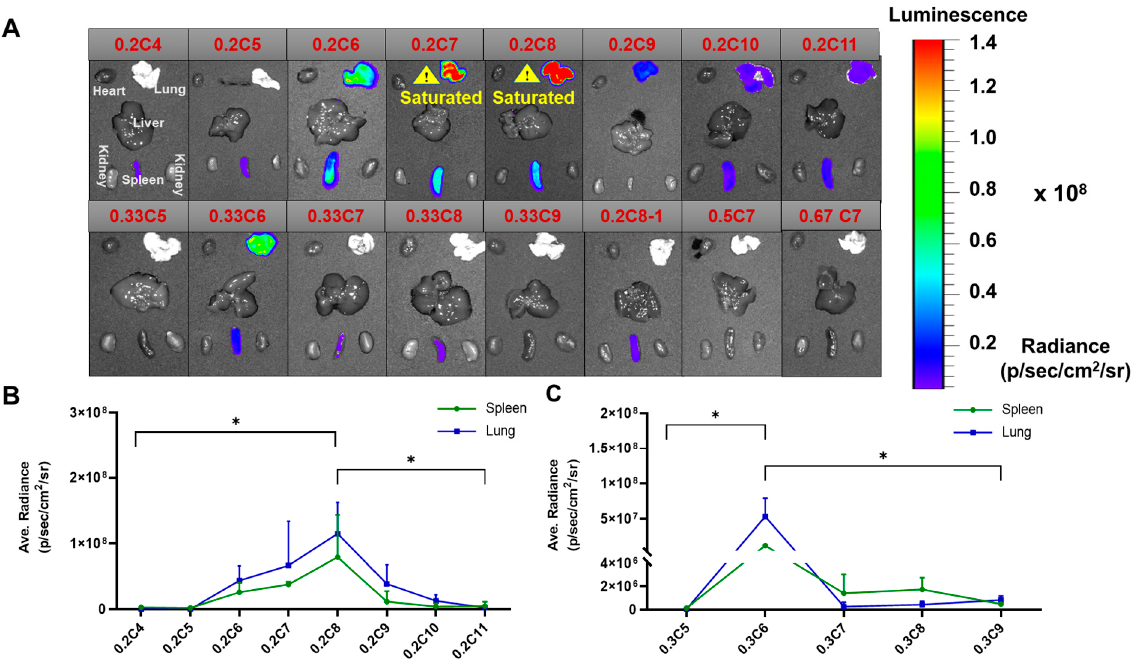
Figure 3. In vivo screening of Luc mRNA delivery. Top functionalized polyesters were examined for their ability to deliver Luc mRNA in vivo. C57BL/6 mice were randomly grouped and intravenously injected with 0.5 mg/kg Luc mRNA ( n = 2). Luminescence was quantified 6 h after injection. ( A ) Ex vivo bioluminescence images of selected polyesters. The yellow triangle denotes detector saturation of signals. ( B , C ) The average luminescence for the spleen and lungs was plotted. The parent polyester was PE4K-A17 for all the above selected functionalized polyesters (mean ± s.d., n = 2, p < 0.05 (*)).